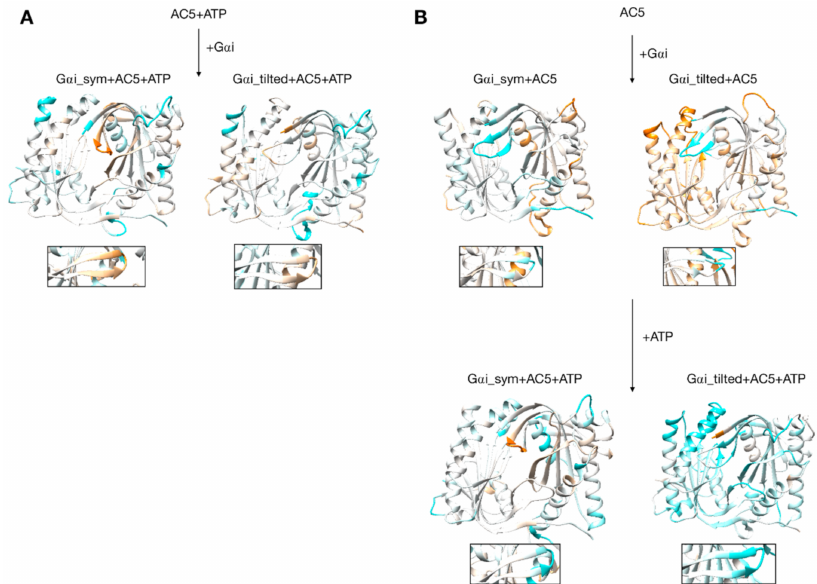
Figure 7. Changes in flexibility induced by G proteins. ( A ) Scenario where ATP is already bound to AC5 when G α i interacts, ( B ) scenario where ATP is not yet bound to AC5 when G α i interacts. More intense colors (orange for increased flexibility and cyan for decreased flexibility) correspond to di ff erences with respect to the preceding structure on a scale of − 1.2 to + 1.2 Å. The insets display the β 4